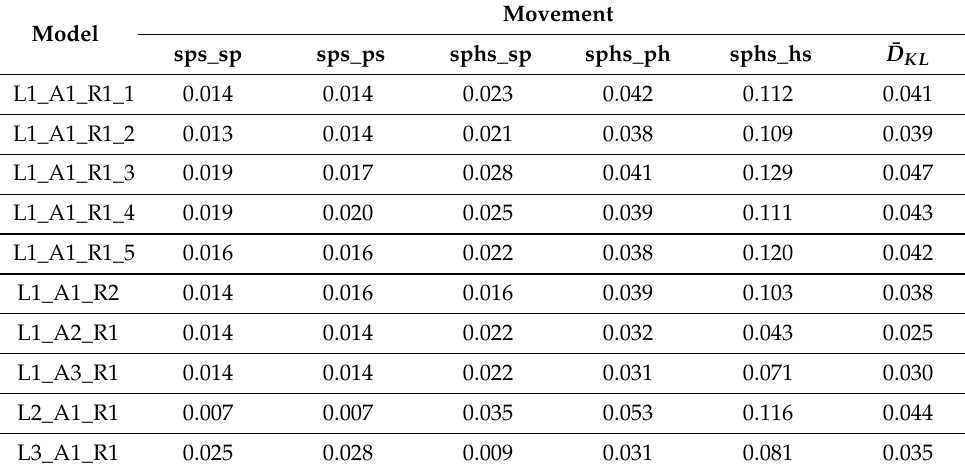
Table 7. The values D KL of the KL divergence measuring the distances between probability density functions of movement lengths obtained by models and trips in the test dataset. In column ¯ D KL , the row averages of D KL values are presented. Model